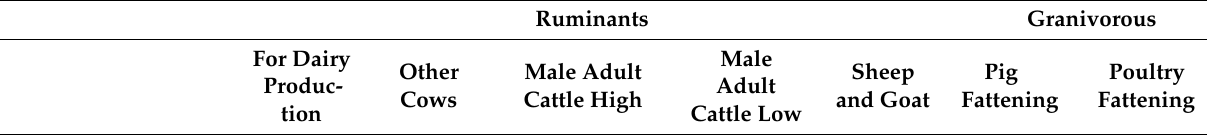
Table 3. Fodder ratio changes due to the cease of imports compared to the baseline in the